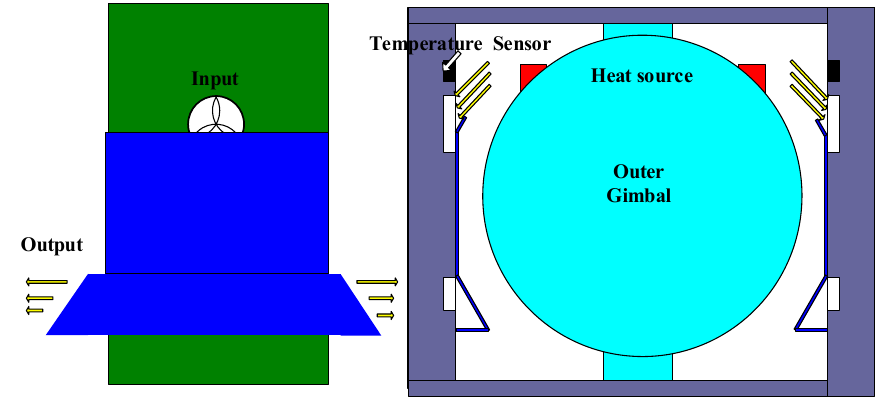
Figure 11. Optimization of the temperature control